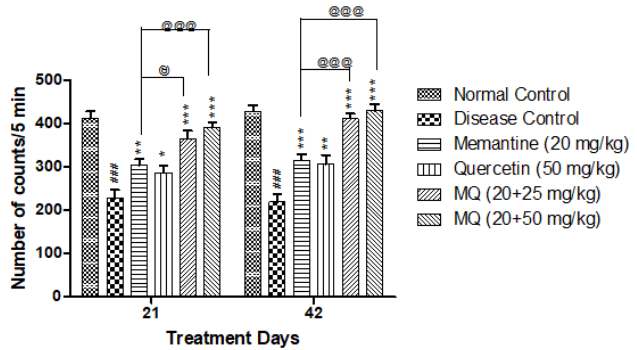
Figure 1. Effect of quercetin and quercetin with memantine on locomotor activity in AlCl 3 -induced neurotoxicity in rats. Data are expressed as mean ± SEM ( n = 6), ### p < 0.001 when compared with the normal control group, * p < 0.05, ** p < 0.01, *** p < 0.001 when compared with the disease control group, and @ p < 0.05, @@@ p < 0.001 when compared with the memantine treatment group; AlCl 3 : aluminum chloride, SEM: standard error of mean.